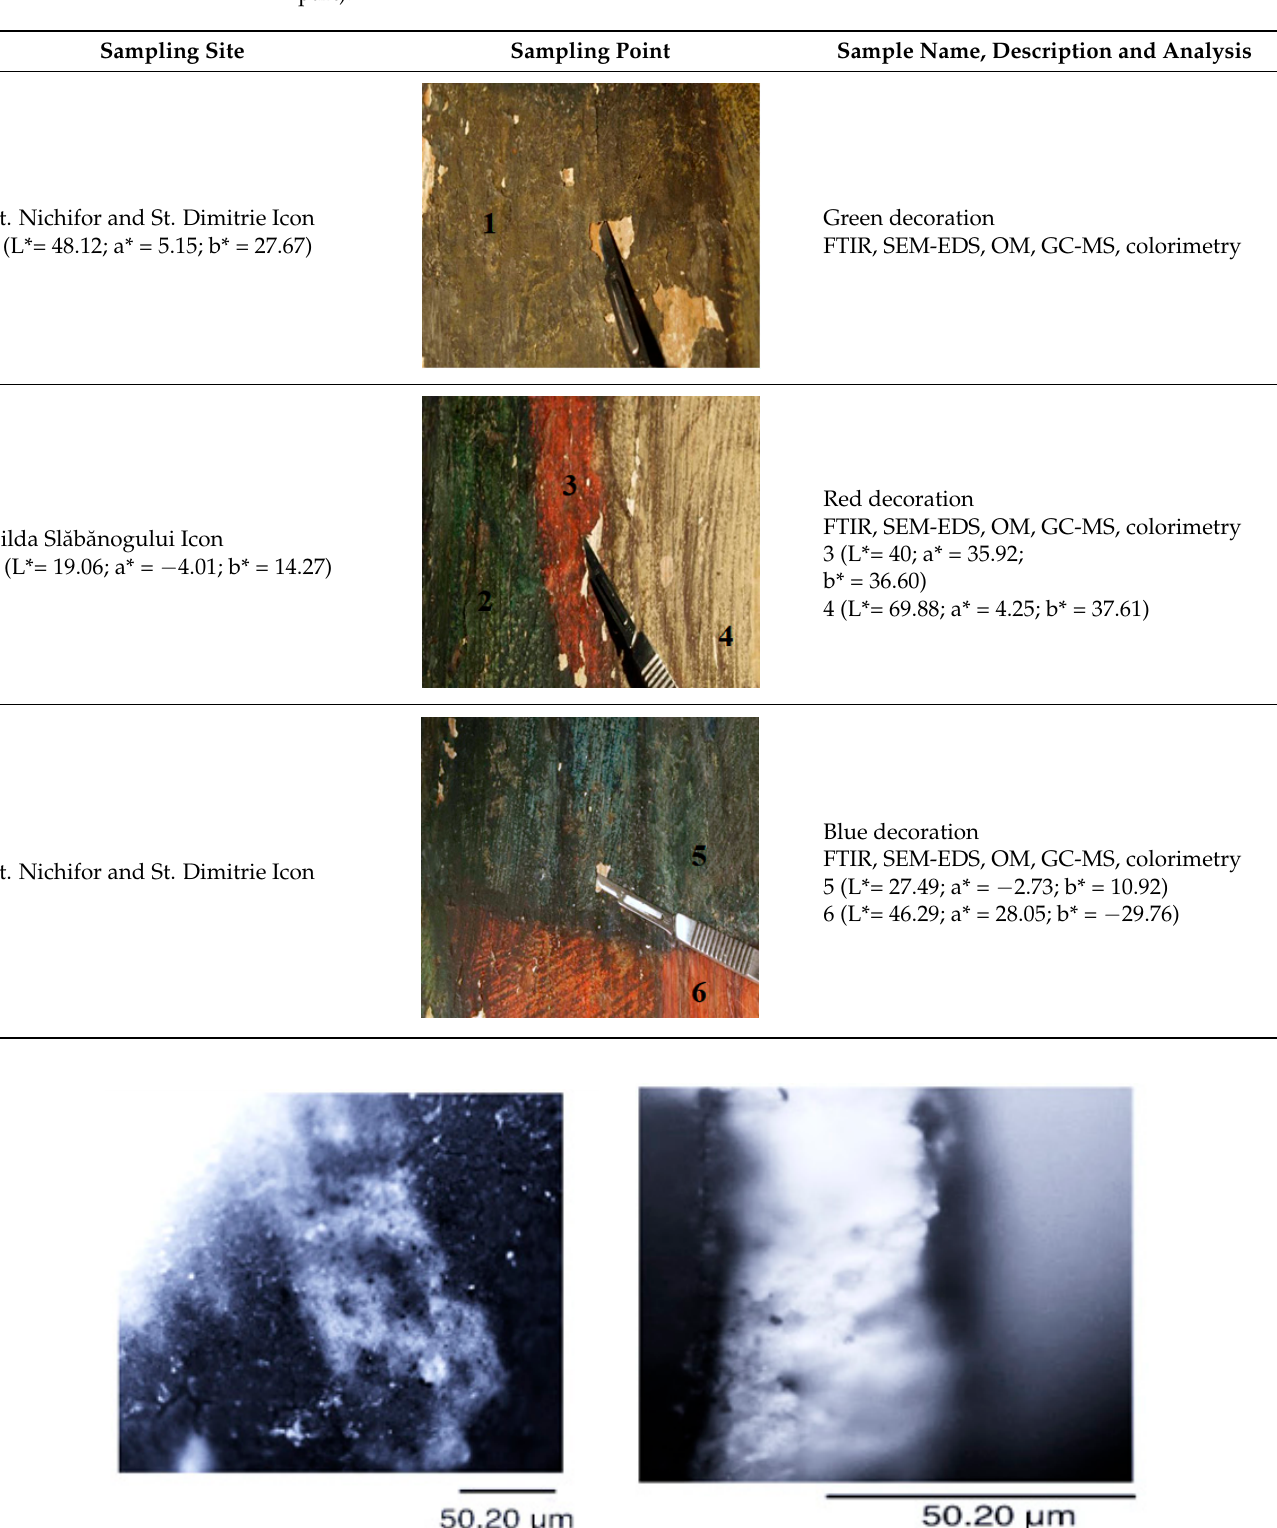
OM is completed with stereomicroscopy, which allows to clearly observe the white layer of metallic soaps formed at the pigment surface, Figure 4. Additionally, by using the microscope tool it was possible to measure the size of the white deposit from the surface painting.